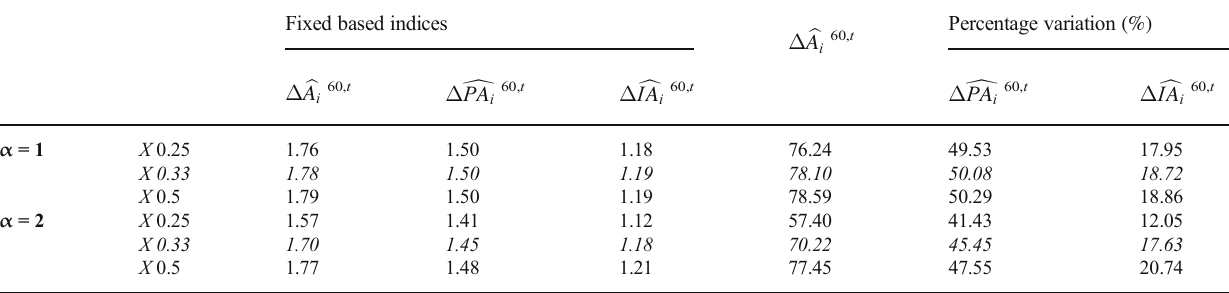
Sensitivity analysis to distance decay value ( α ), internal travel distance constant used (X) Fixed based